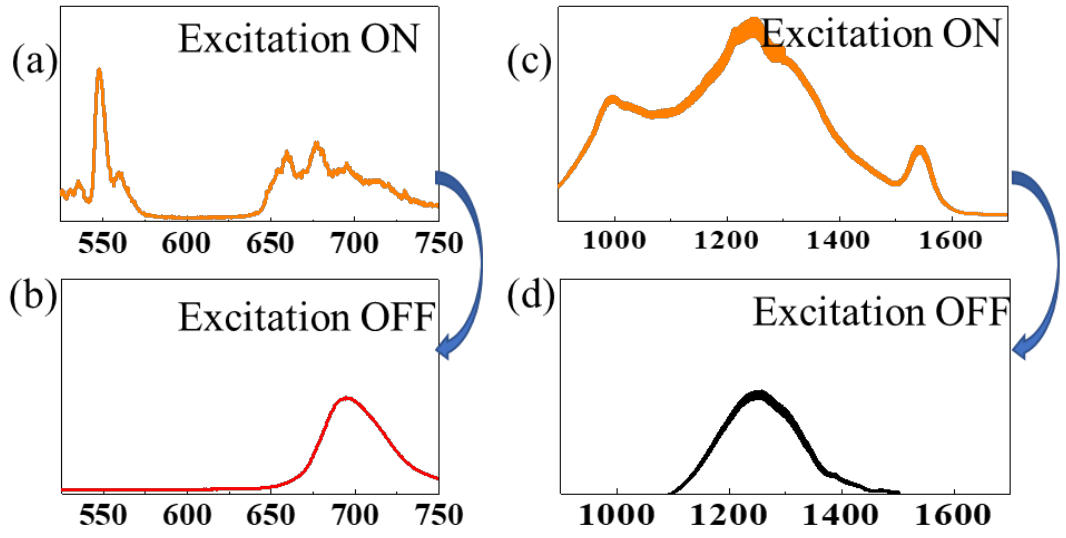
Figure 6. ( a ) Spectrum of PL (excitation ON) and ( b ) persistent luminescence (excitation OFF) detected with Si-based detector; ( c ) spectrum of PL (excitation ON) and ( d ) persistent luminescence (excitation OFF) detected with an InGaAs detector. All the PL or persistent luminescence spectra were from ZGSO-3:Ni, Cr, Er NPs under excitation or after excitation by the 365 nm UV lamp for 5 min, respectively.